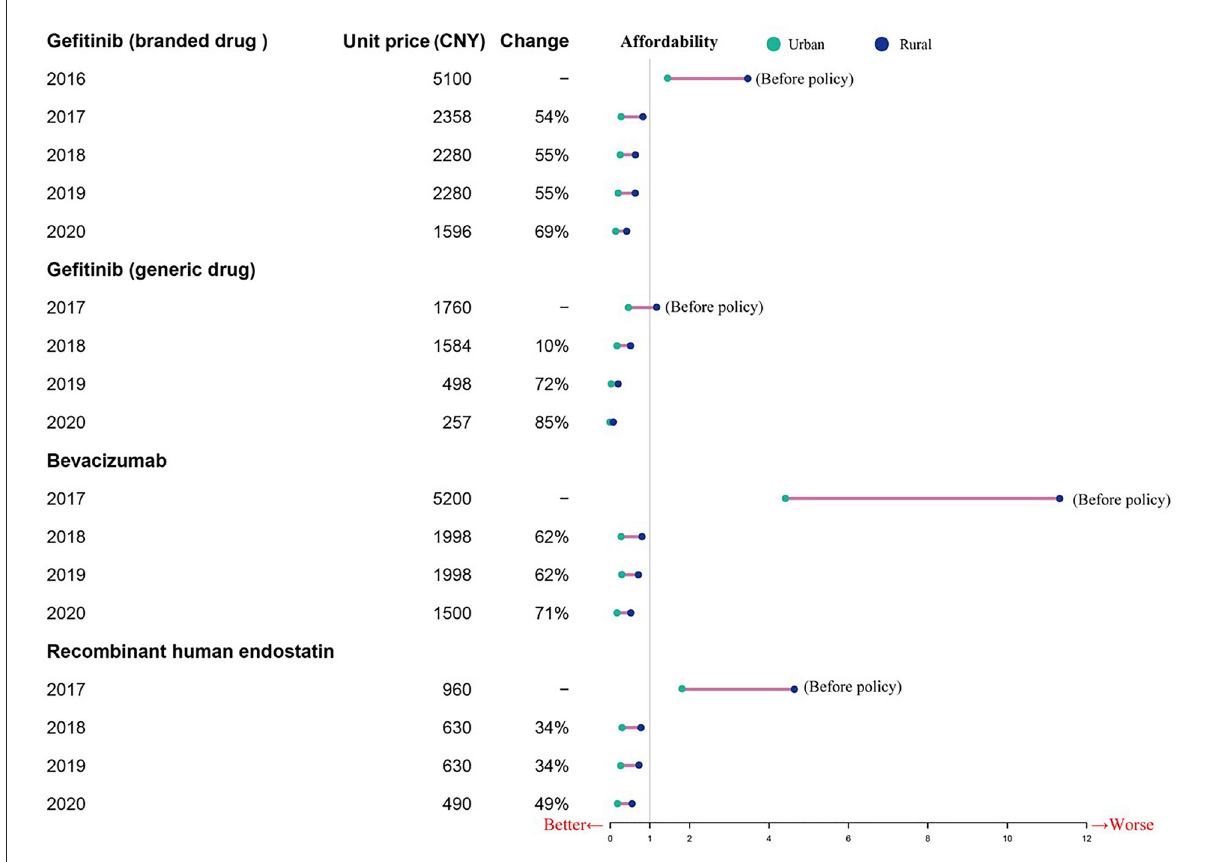
FIGURE3 Change in affordability for mPFS treatment courses between urban areas and rural